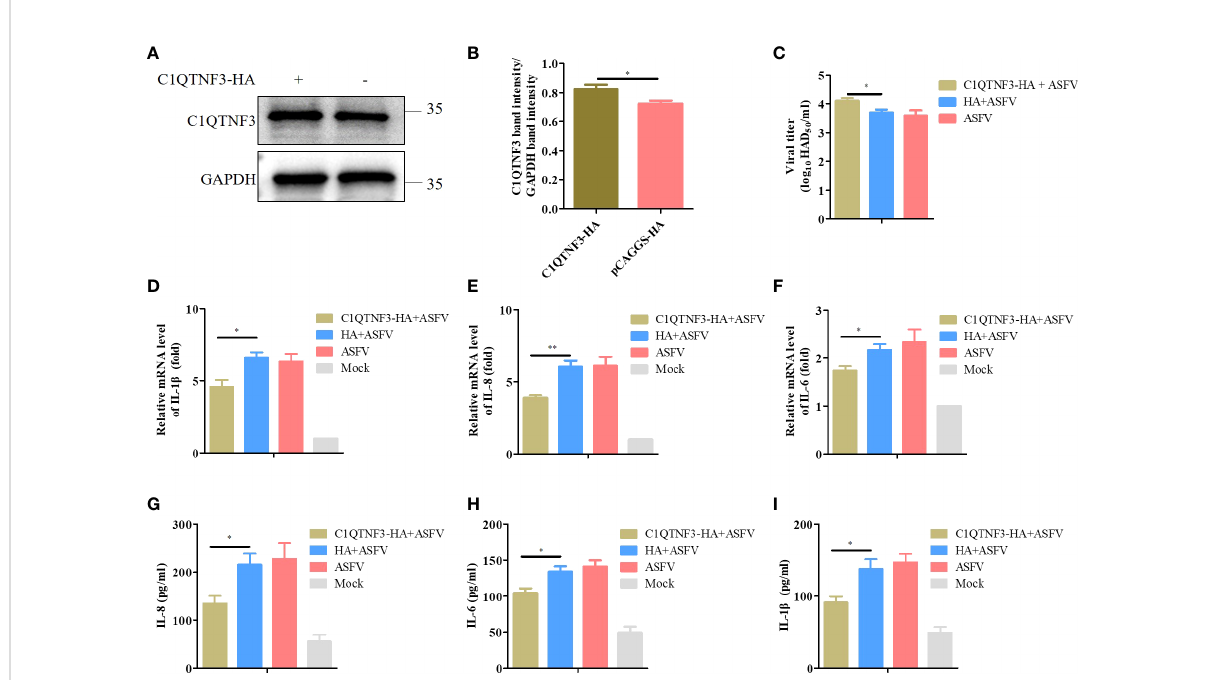
FIGURE 6 Downregulated pro-in fl ammatory cytokines increase ASFV infection in PAMs. (A, B) Overexpression of HA-tagged C1QTNF3 proteins was detected using western blot analysis. (C) C1QTNF3 overexpression in PAMs increases ASFV replication as detected using the HAD assay. The mRNA levels of (D) IL-1 b , (E) IL-8, and (F) IL-6 upon C1QTNF3 overexpression in PAMs infected with ASFV. The GAPDH gene was used as the internal control for normalization. The 2 - DD Ct method was used to analyze the results of qPCR. The protein levels of (G) IL-8, (H) IL-6, and (I) IL- 1 b upon C1QTNF3 overexpression in PAMs infected with ASFV p <0.05 (*), p < 0.01